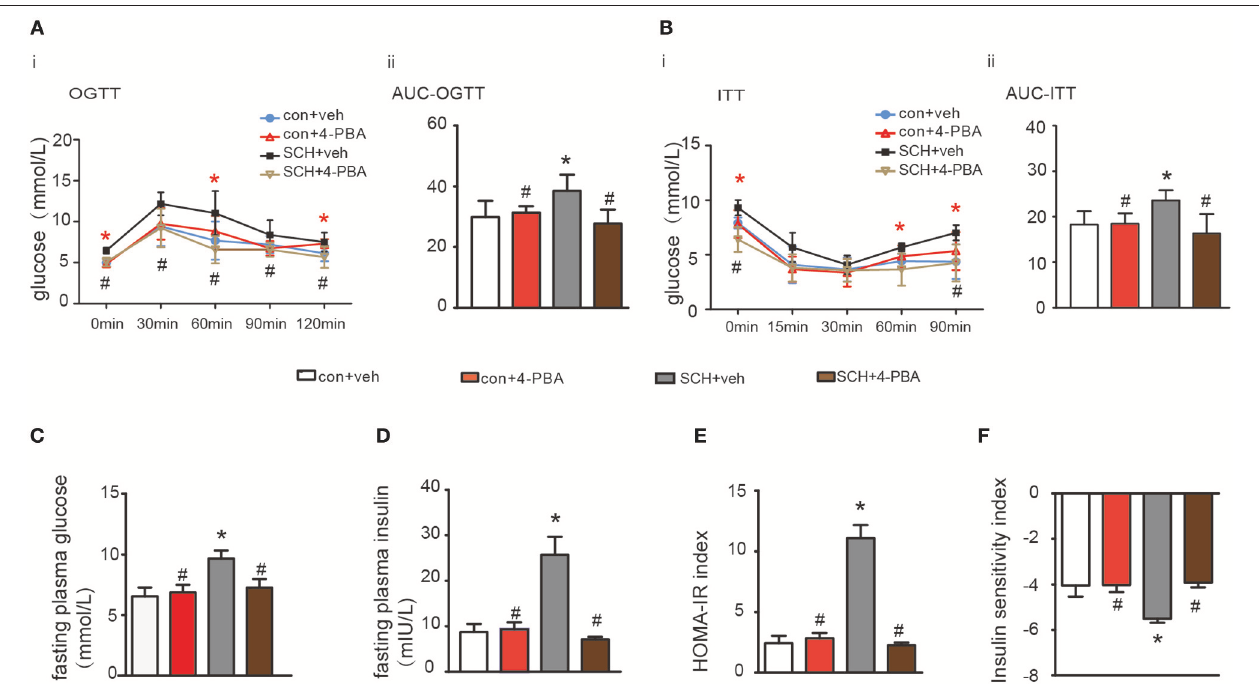
FIGURE 5 | 4-PBA alleviated abnormal glucose metabolism and IR in SCH mice. (A) Oral glucose tolerance test (OGTT) was implemented to detect glucose tolerance at the 17th week of administering MMI to mice in the drinking water ( n = 4–6). (B) Insulin tolerance test (ITT) was implemented to assess insulin-stimulated glucose disposal at the 18th week of administering MMI to mice in the drinking water ( n = 4–6). (C) The fasting plasma glucose level was assayed at the 18th week ( n = 3–4). (D) The fasting plasma insulin level was assayed at the 18th week ( n = 3–4). (E) Homeostasis Model Assessment-Insulin Resistance (HOMA-IR) index was calculated. (F) Insulin sensitivity index (ISI) was calculated. The data are presented as the mean ± SD. * p < 0.05 compared with vehicle treated mice group. # p < 0.05 compared with 4-PBA treated SCH mice